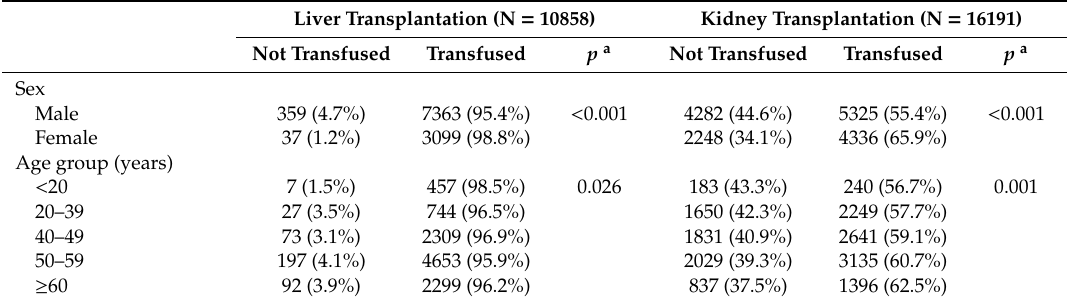
Table 1. Transfusion needs by baseline characteristics of liver and kidney transplantation recipients in Korea,